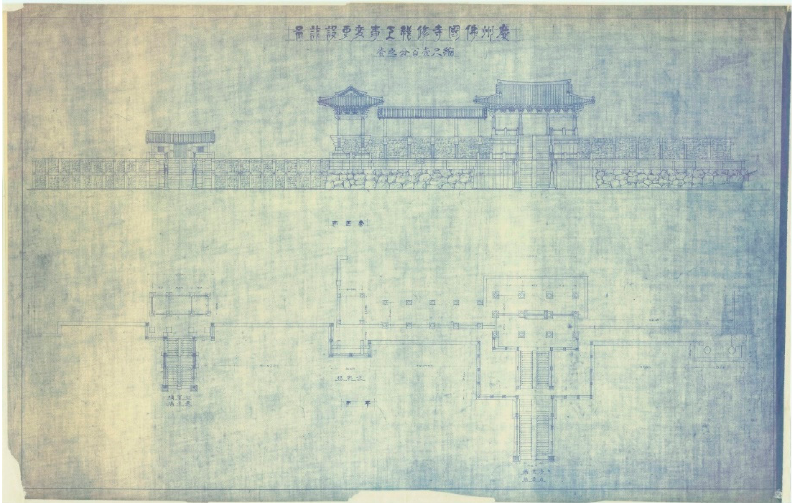
Figure 19. Restoration Plan (a line drawing between 1918 and 1924) on the basis of Sekino’s photo (Gukgagirokwon).